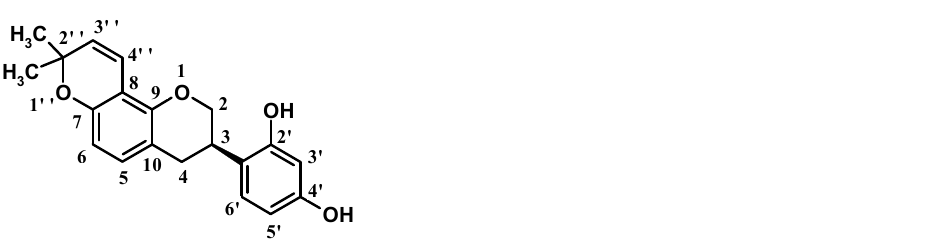
Figure 1. Structure of glabridin. Numbers on the Structure of glabridin are used to distinguish the same functional groups at different positions.